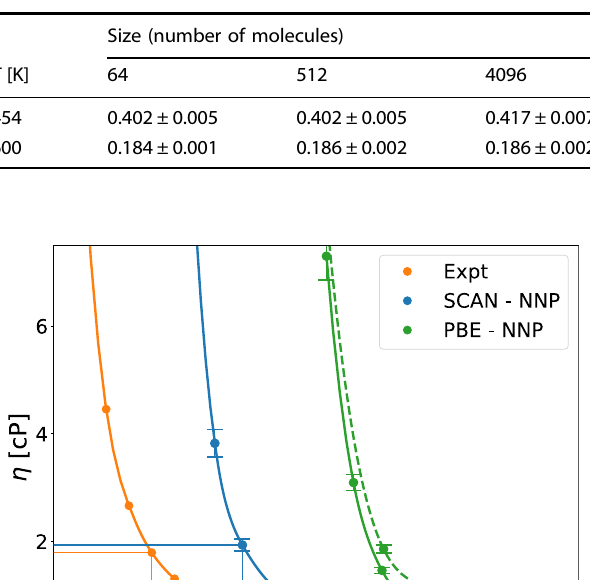
Table 2. Shear viscosity [cP] computed for water at different temperatures with PBE-NNP force fi eld and using simulation boxes of different